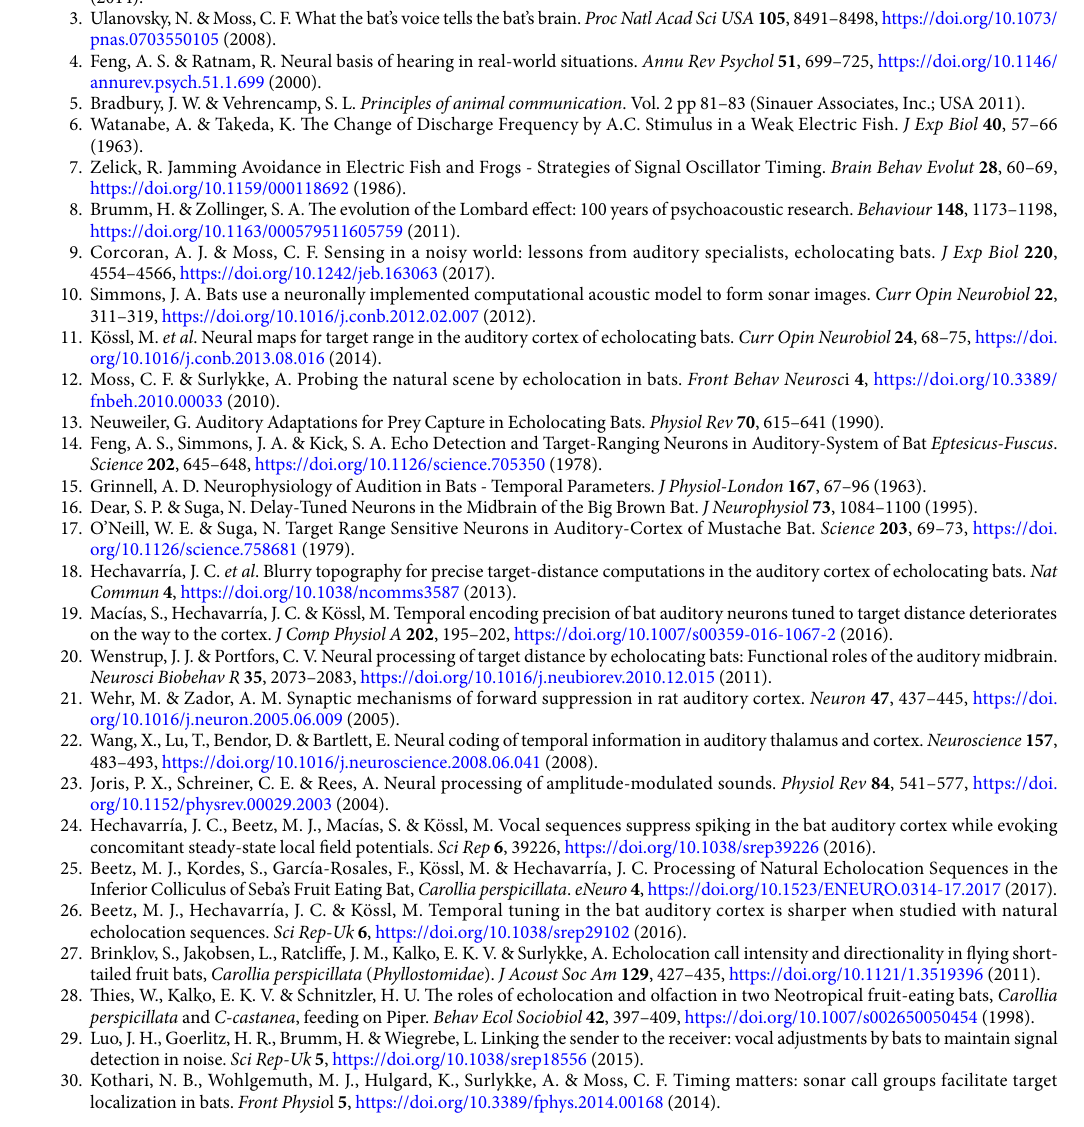
The higher the neuron’s cumulative d’, the higher is its target detection in the mixture situation. The quantification of target detection based on d’ have been successfully performed in previous studies 42,43 . Data analysis was done in Matlab 2014 and statistics in GraphPad Prism 5 (GraphPad Software, USA; * p < 0.05; ** p < 0.01; *** p <